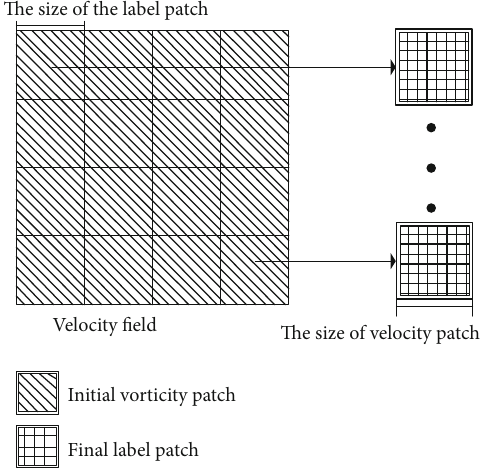
Figure 3: In the test phase, the data is sequentially sampled according to the size of the data patches during the training phase, and the vorticity fi eld is divided evenly into several local small patches.